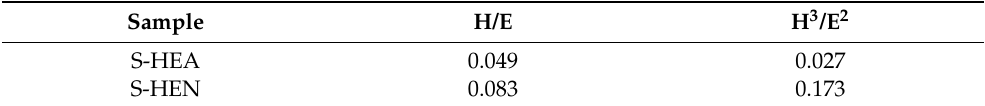
Table 6. The H/E and H 3 /E 2 of HEA and HEN films.